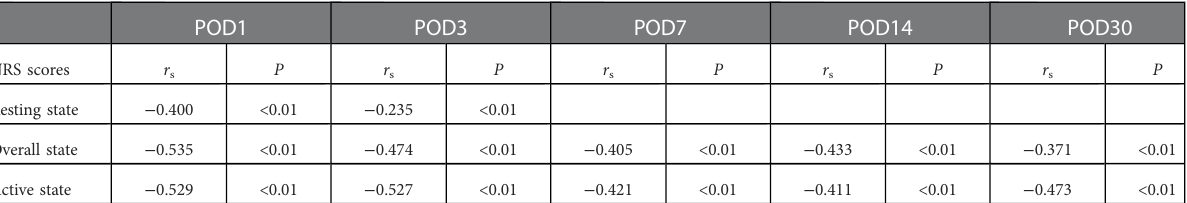
TABLE 2 Correlation of NRS and EQ-VAS scores after surgery.